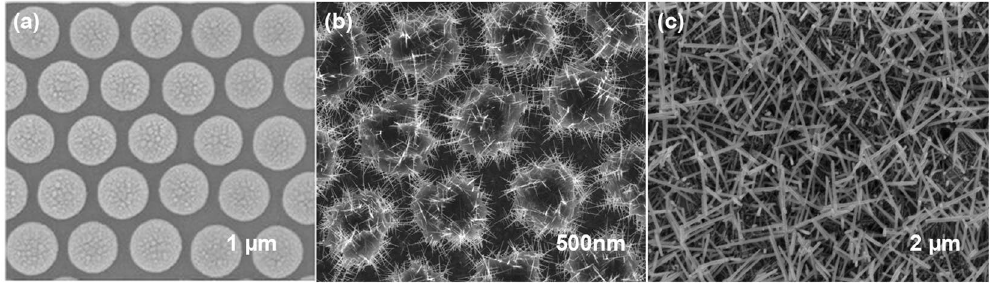
Figure 1. ( a ) PS assembly on wafer, ( b ) ITO NWs deposited on samples, ( c ) PS lift-off and ITO NW networks fabricated.